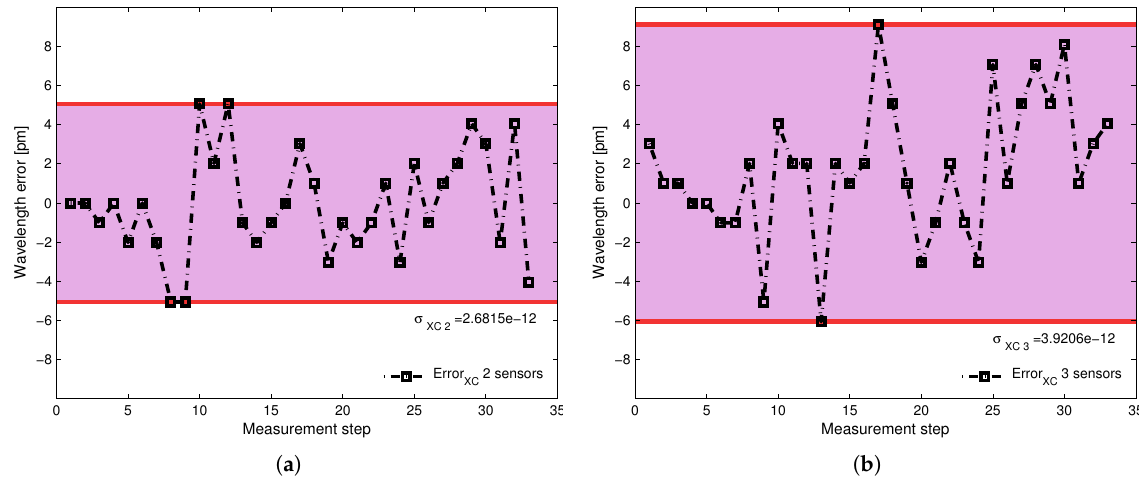
Figure 10. Error found for the isolated sensor after comparison with the detected wavelength in presence of a second sensor ( a ), and after comparison with two additional sensors interacting in the same spectral range ( b